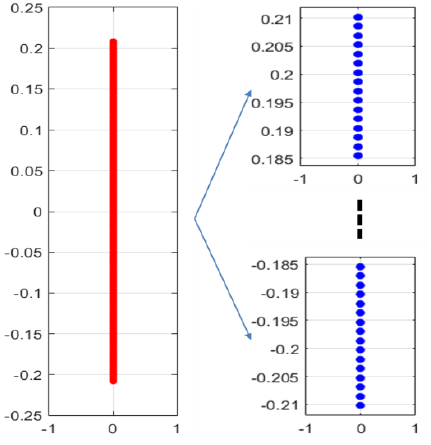
Figure 3. Array divided into 16 subarrays.